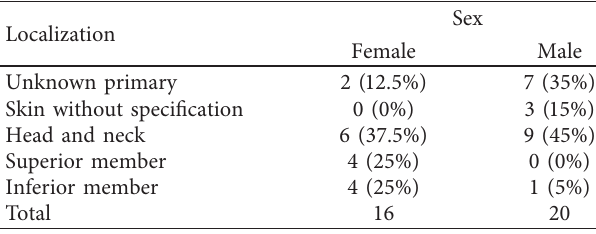
Table 3: Localization by sex.